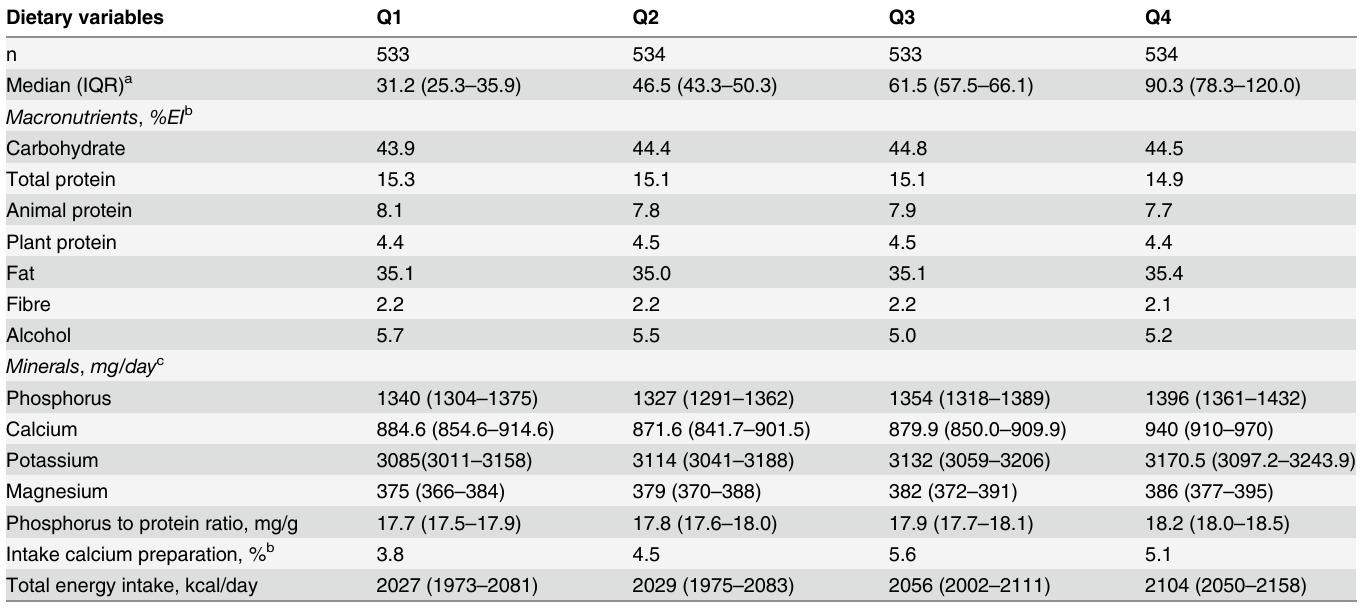
Table 2. Dietary characteristics (potential predictors) of EPIC-Germany participants according to sex specific quartiles (Q) of FGF23 levels. Dietary variables Q1